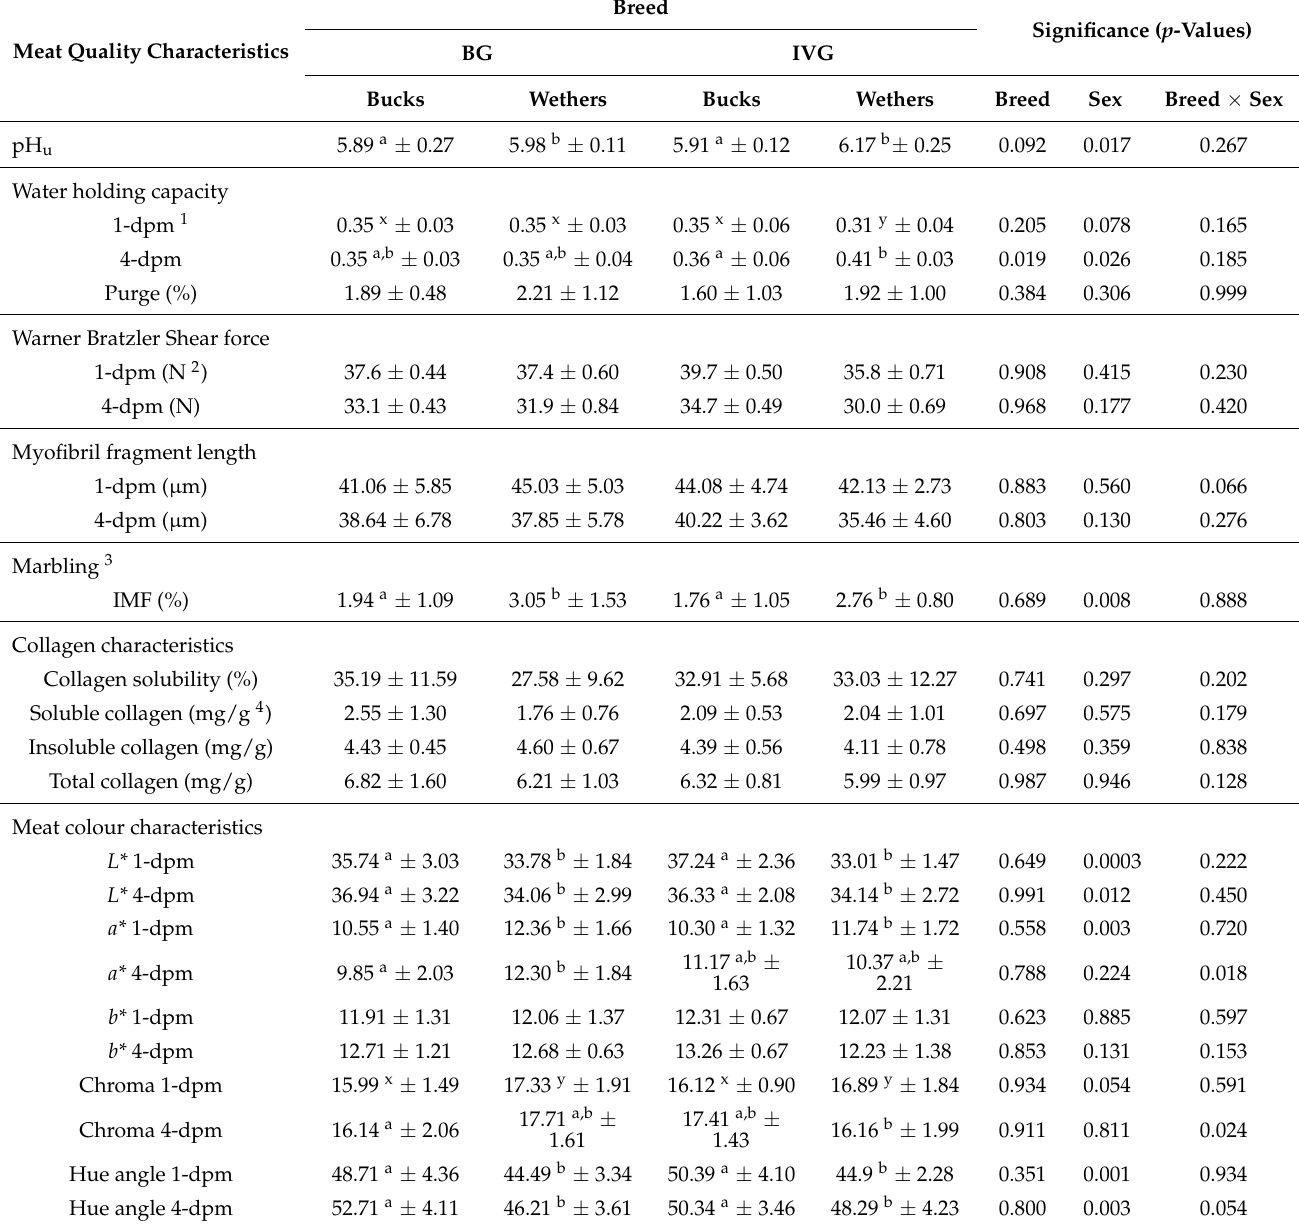
Table 5. Least square means and standard error of means for meat tenderness, meat colour and related physiological characteristics of buck and wether Boer Goats (BG) and Indigenous Veld Goats (IVG) of Supraspinatus (SS)